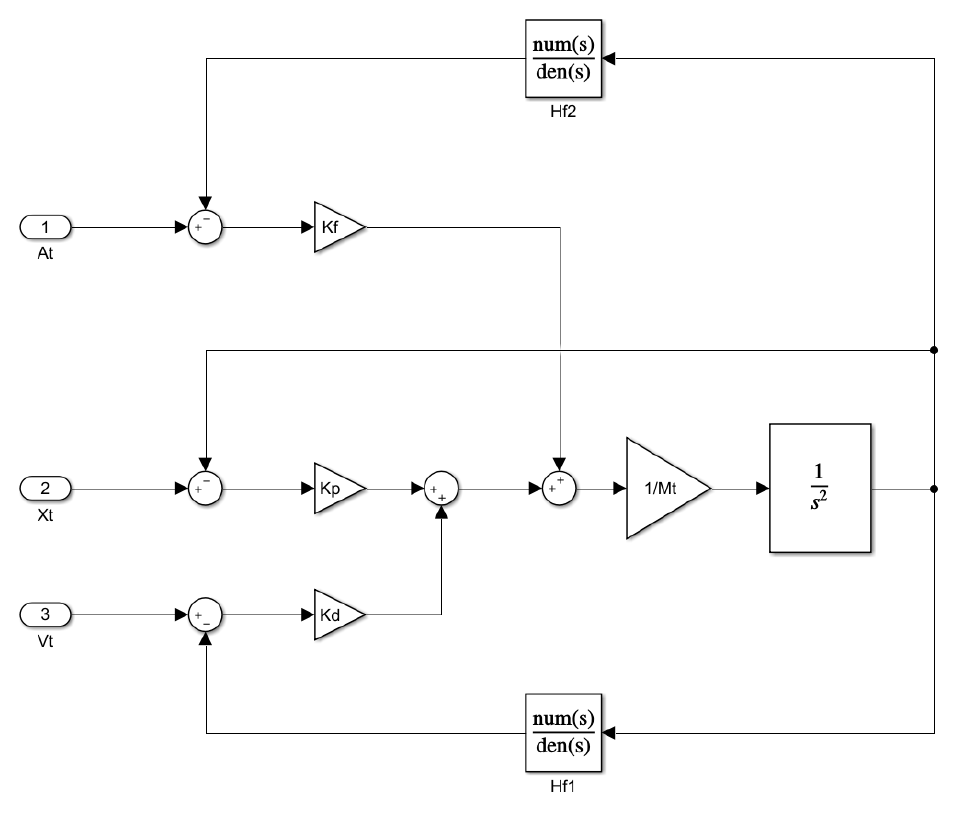
Figure 6. Controller’s block